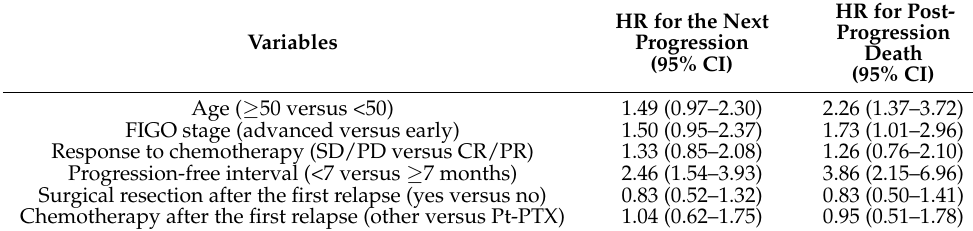
Table 6. Multivariate analysis of prognostic factors in OCCC patients with first relapse ( n = 186).